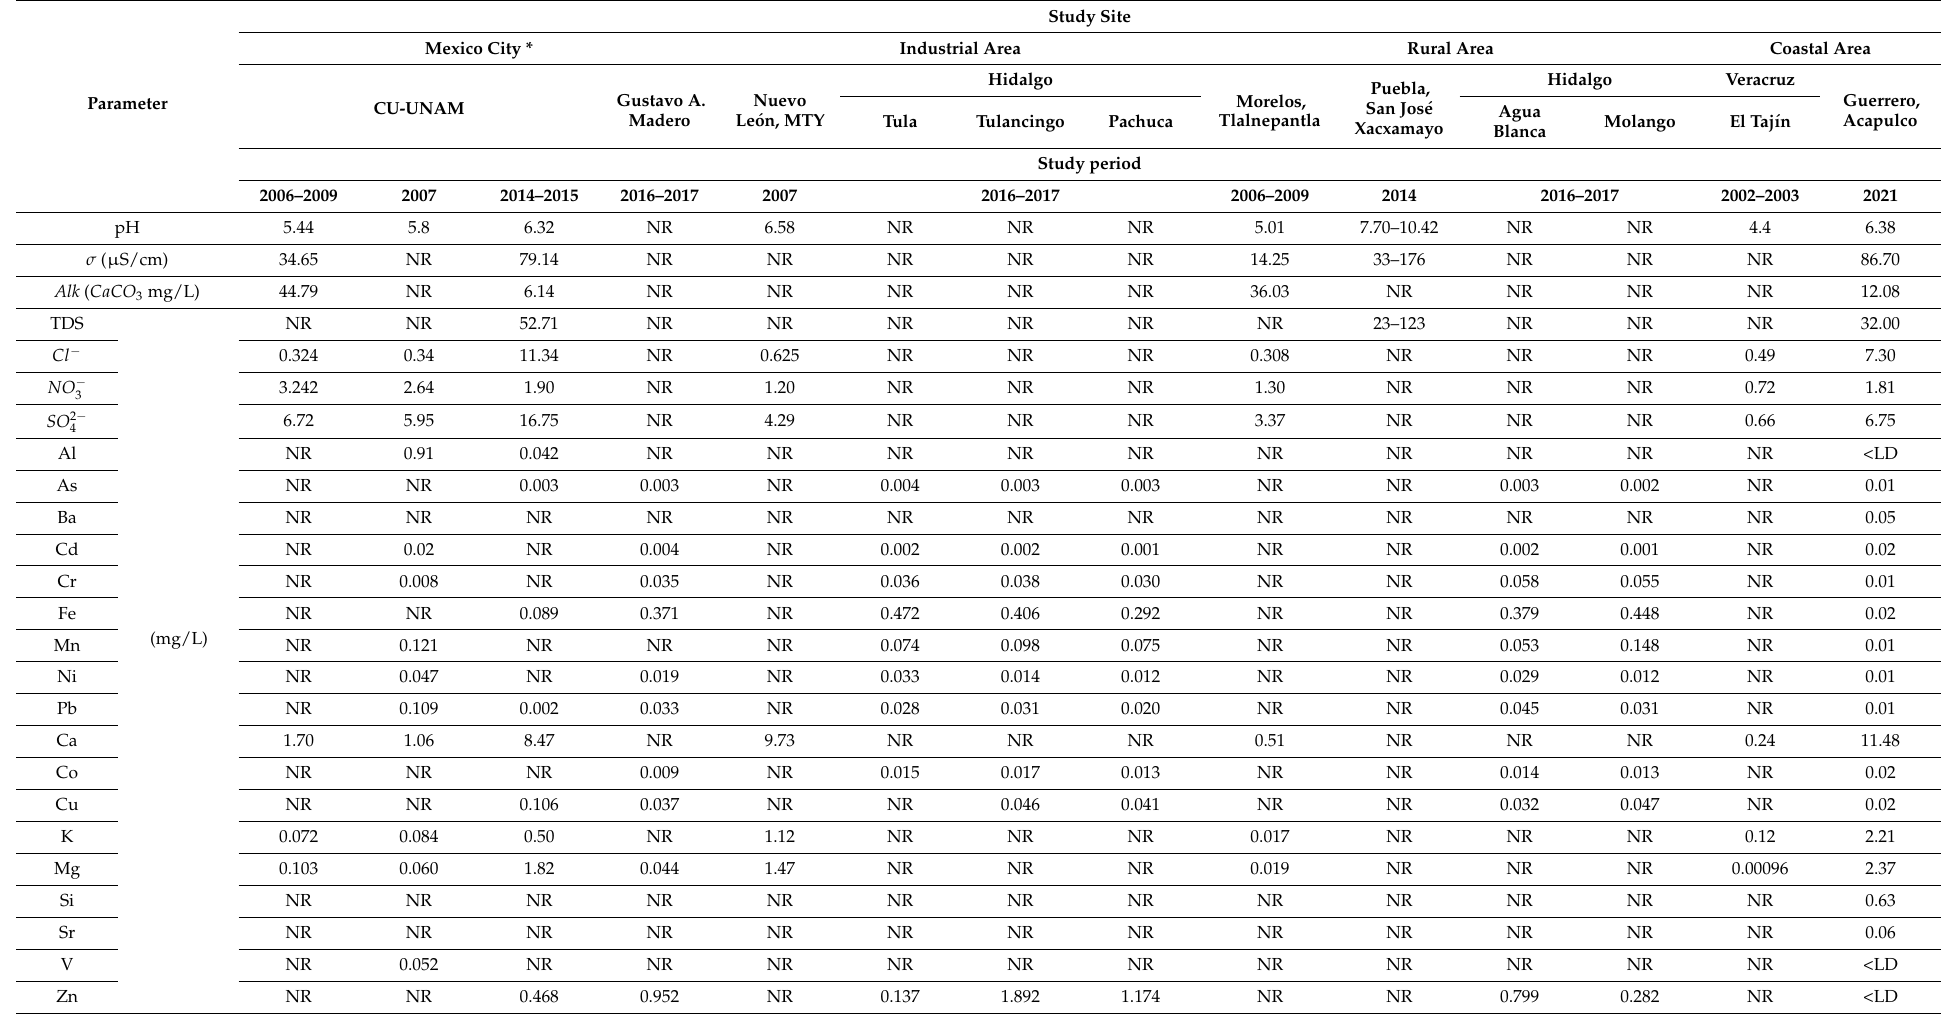
Table 4. Quality of rainwater collected in